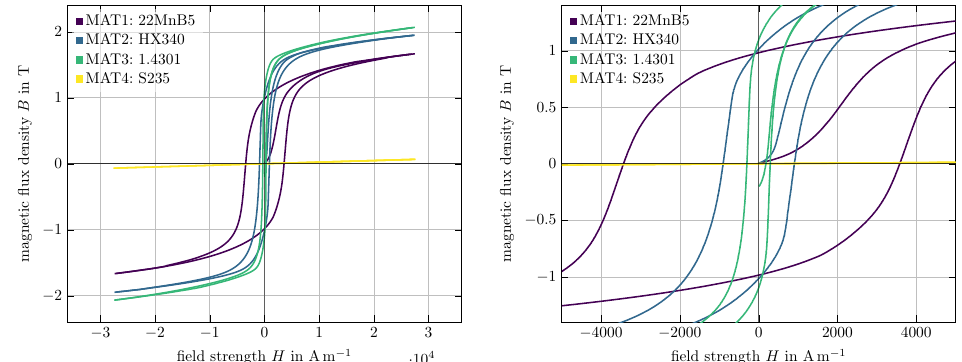
Figure 8. Measurement results of the toroidal rings of the base materials MAT1 to MAT4 in full scale ( left ) and in detail ( right ).